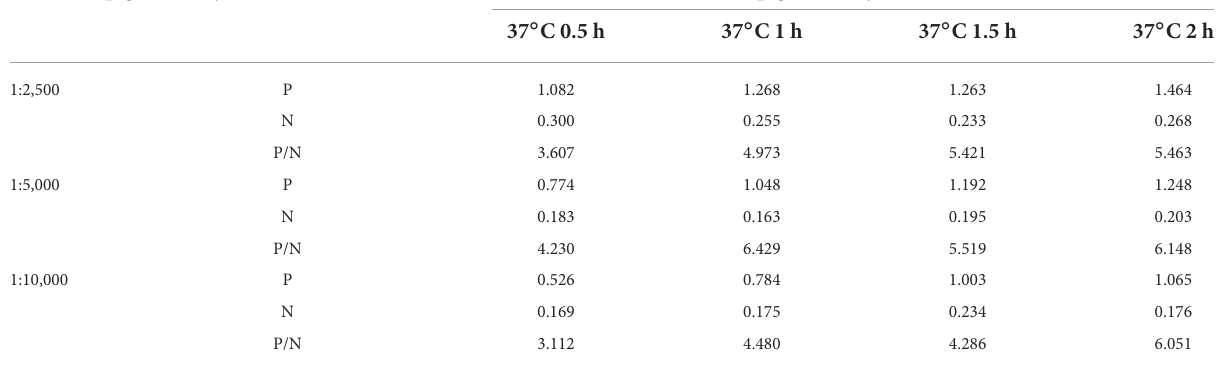
TABLE 2 HRP-conjugated anti-pig working